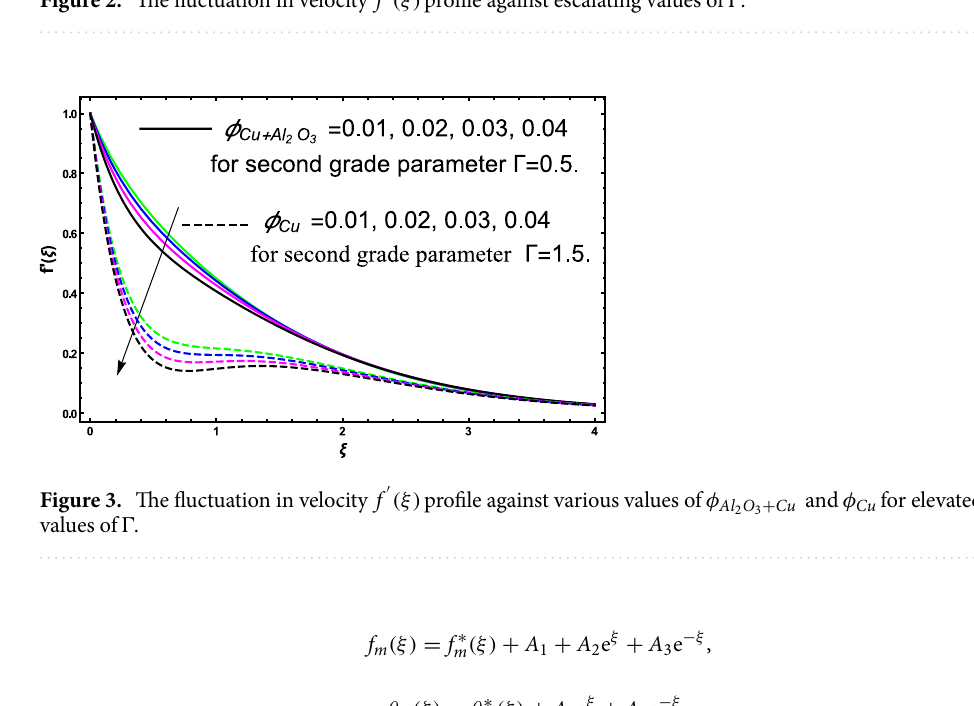
Figure 2. The fluctuation in velocity f